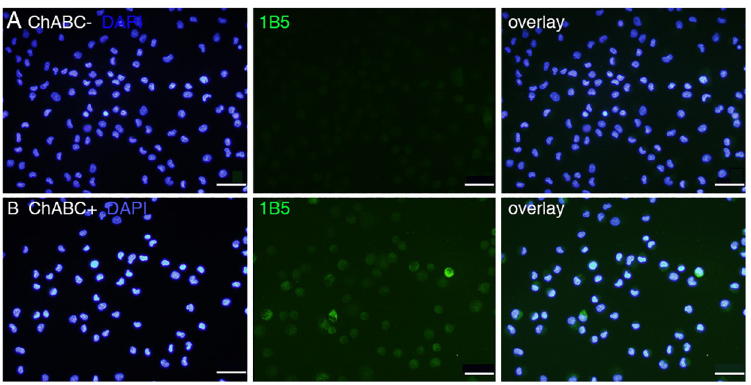
Fig 2. Immunocytochemical staining of CS stub in expanded SCE-UCBCs. Representative photomicrographs of the staining of 1B5 (unsulfated CS stub) monoclonal antibody in expanded SCE-UCBCs. Immunoreactivity was only observed in the cells pre-digested with Chase ABC (B), and not in the cells not digested with Chase ABC (A, see Methods). blue, DAPI; green, 1B5 antibody. Bar, 50 μ m.